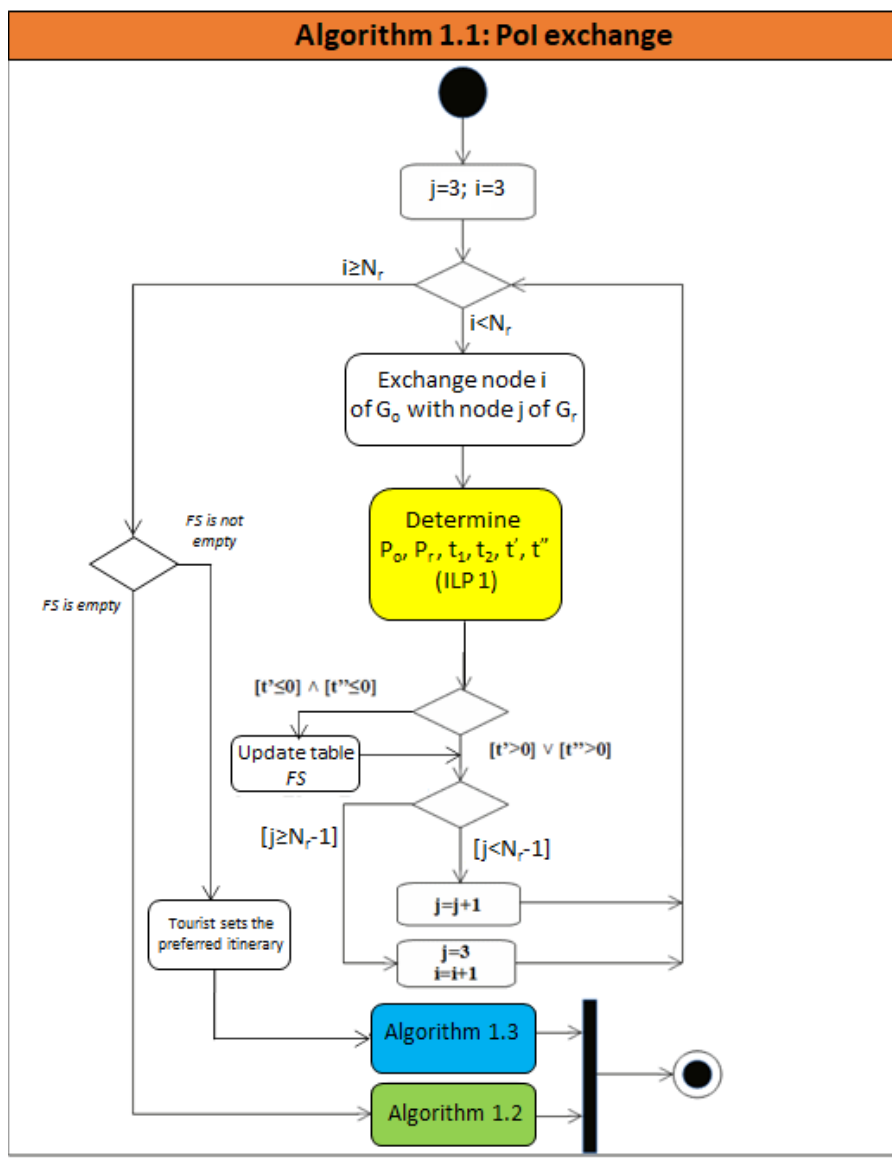
Figure 3. The UML diagram for the node exchange procedure. Algorithm 1.2: PoI Deletion Procedure Algorithm 1.2 starts the node deleting procedure (see UML diagram of Figure